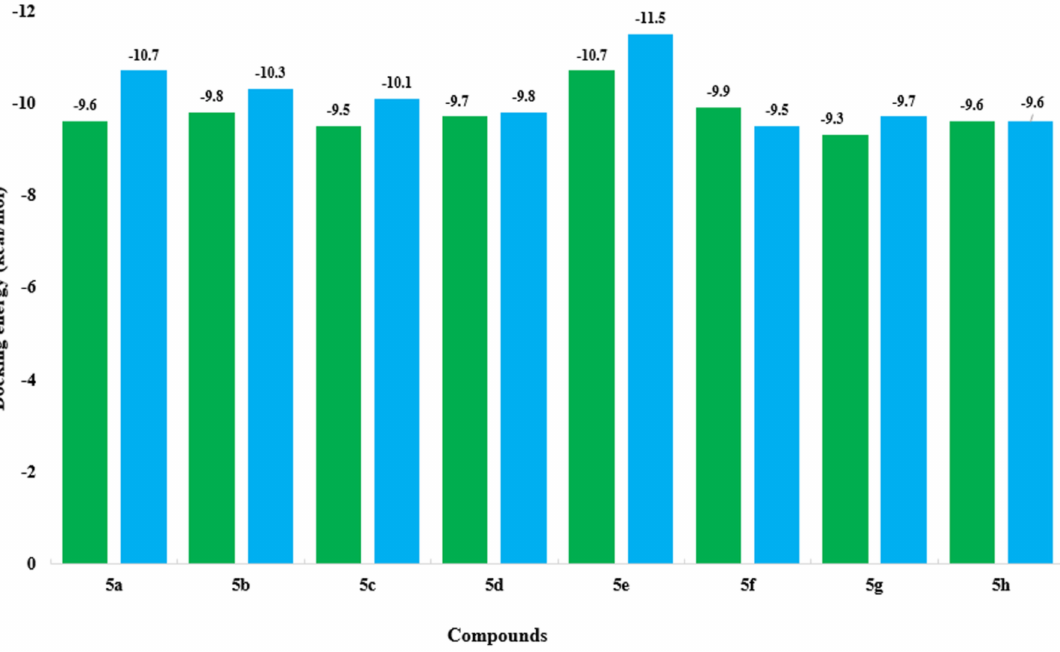
Figure 5. Energy graph of both α -amylase and α -glucosidase docking (the green bar shows α -amylase, and the blue bars show α -glucosidase).